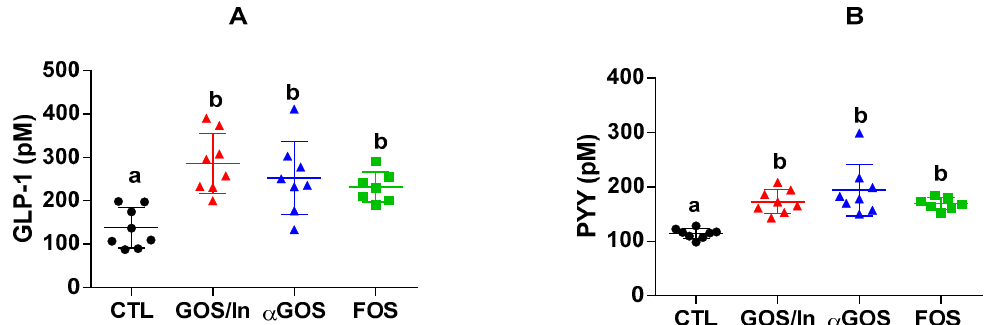
Figure 5. Plasma concentration of ( A ) Total GLP-1; ( B ) Total PYY at PND 14/15. Different letters indicate significant differences among groups ( p < 0.05). Individual, mean and SD values are plotted ( n = 7 to 8 per group).